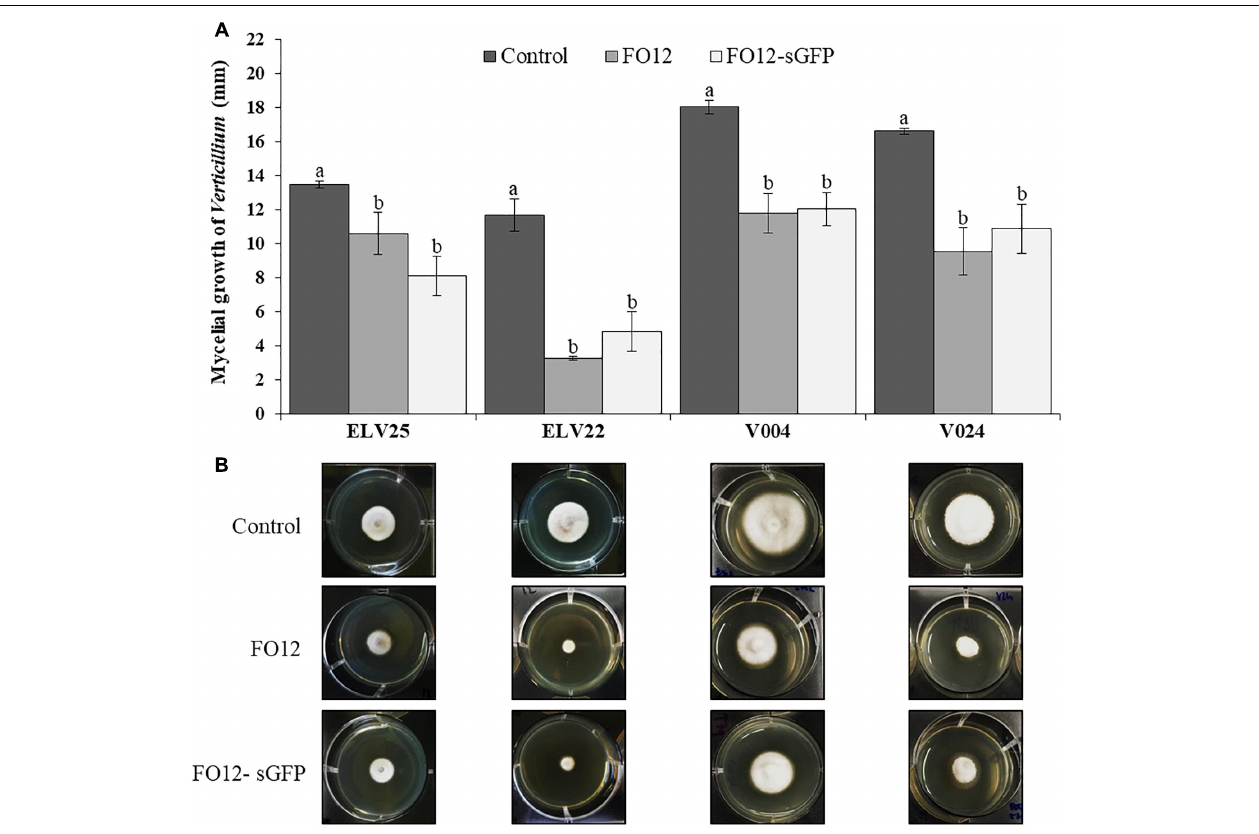
FIGURE 1 | Effect of volatile organic compounds (VOCs) from the non-pathogenic F. oxysporum strain FO12 and from the GFP-labeled FO12 (FO12-sGFP) against the mycelial growth of V. longisporum ELV25 and V. dahliae isolates ELV22, V004 and V024 (A) . For each isolate, columns represent the means of 12 replicates per treatment. Vertical lines in each column are the standard error of the mean. For each Verticillium isolate, means in a column followed by different letters are significantly different according to Fisher’s protected least significant differences (LSD) test at P = 0.05. (B) Pictures below illustrate the mycelial growth of each Verticillium isolate according to the different